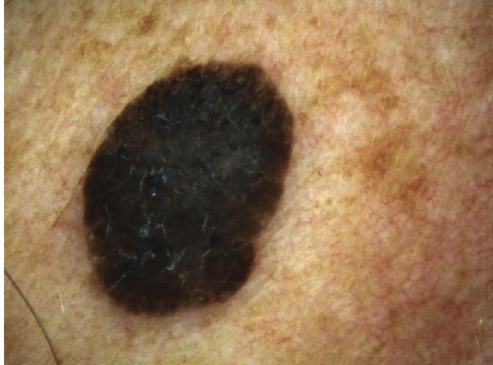
Figure 4. Melanoacanthoma. This figure is an original image created by the author for this publication and written informed consent was obtained from the patient.